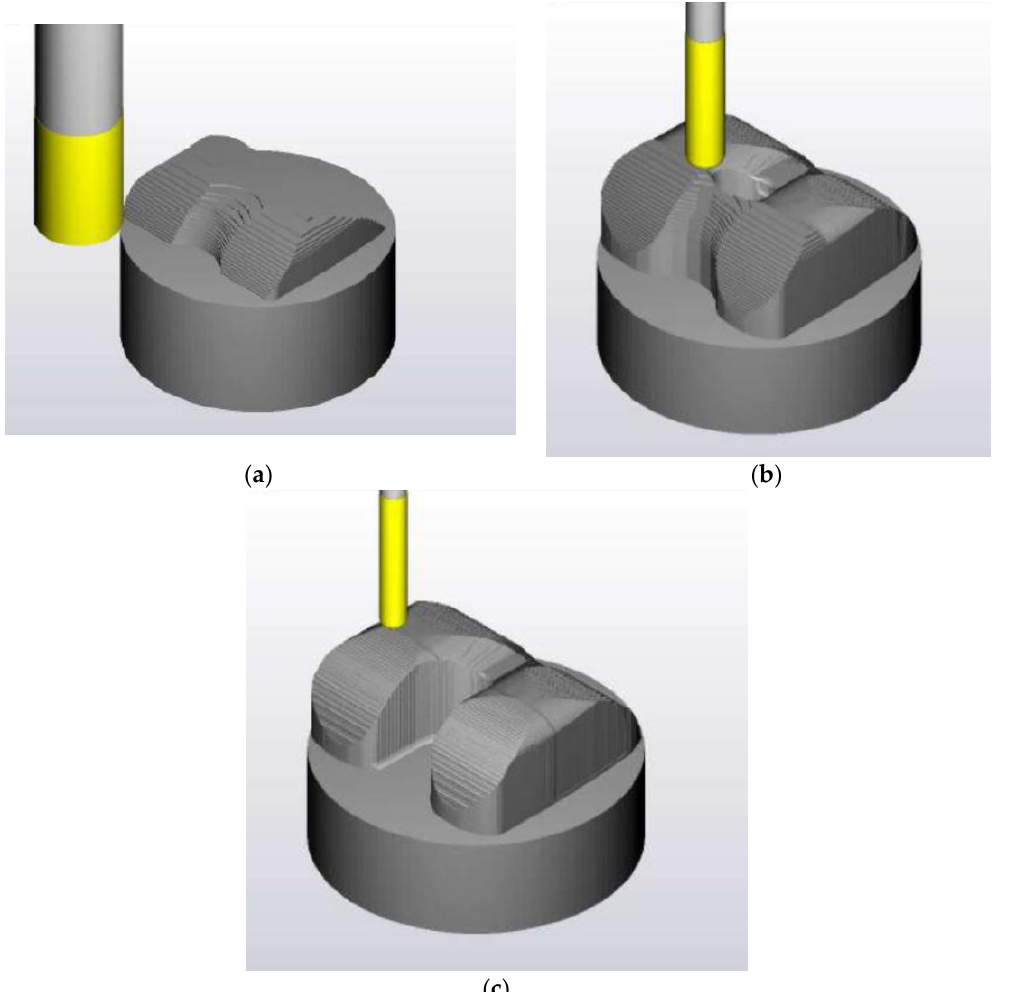
Figure 4. Snapshots from the simulation of the second machining stage: ( a ) Roughing stage of the second machining phase using 16 mm diameter tool; ( b ) Machining of sculptured surface of the femoral component using 6 mm ball end tool; and, ( c ) Finishing stage of the second machining phase, using 4 mm diameter ball end tool.